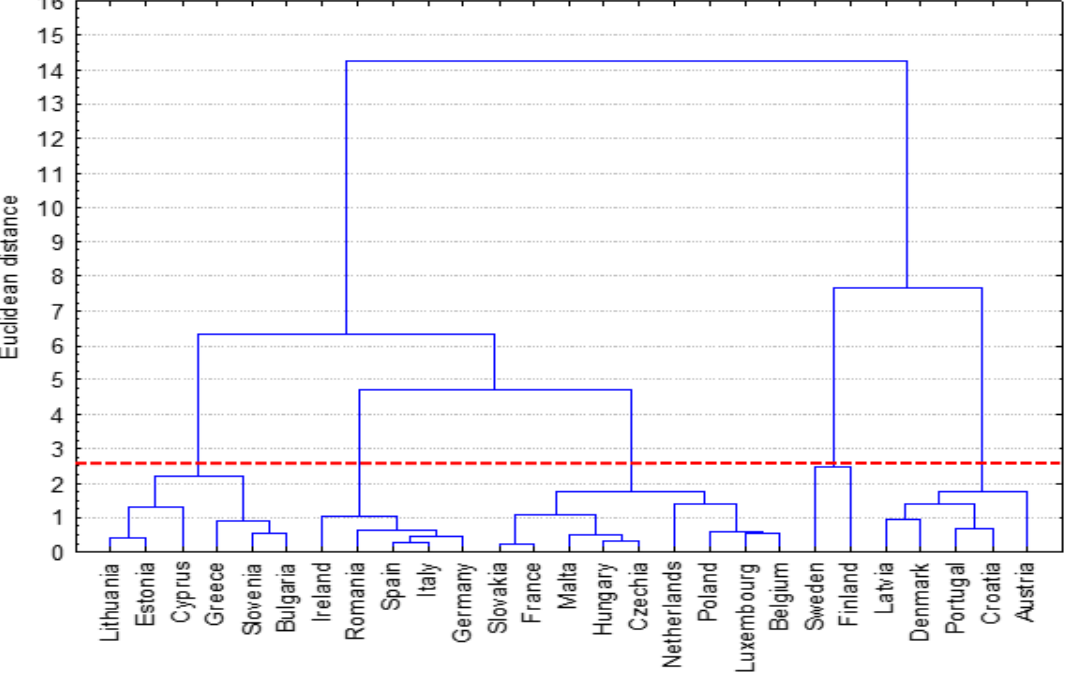
Figure 3. Tree diagram: hierarchical cluster analysis of renewable energy consumption in European countries in 2019.